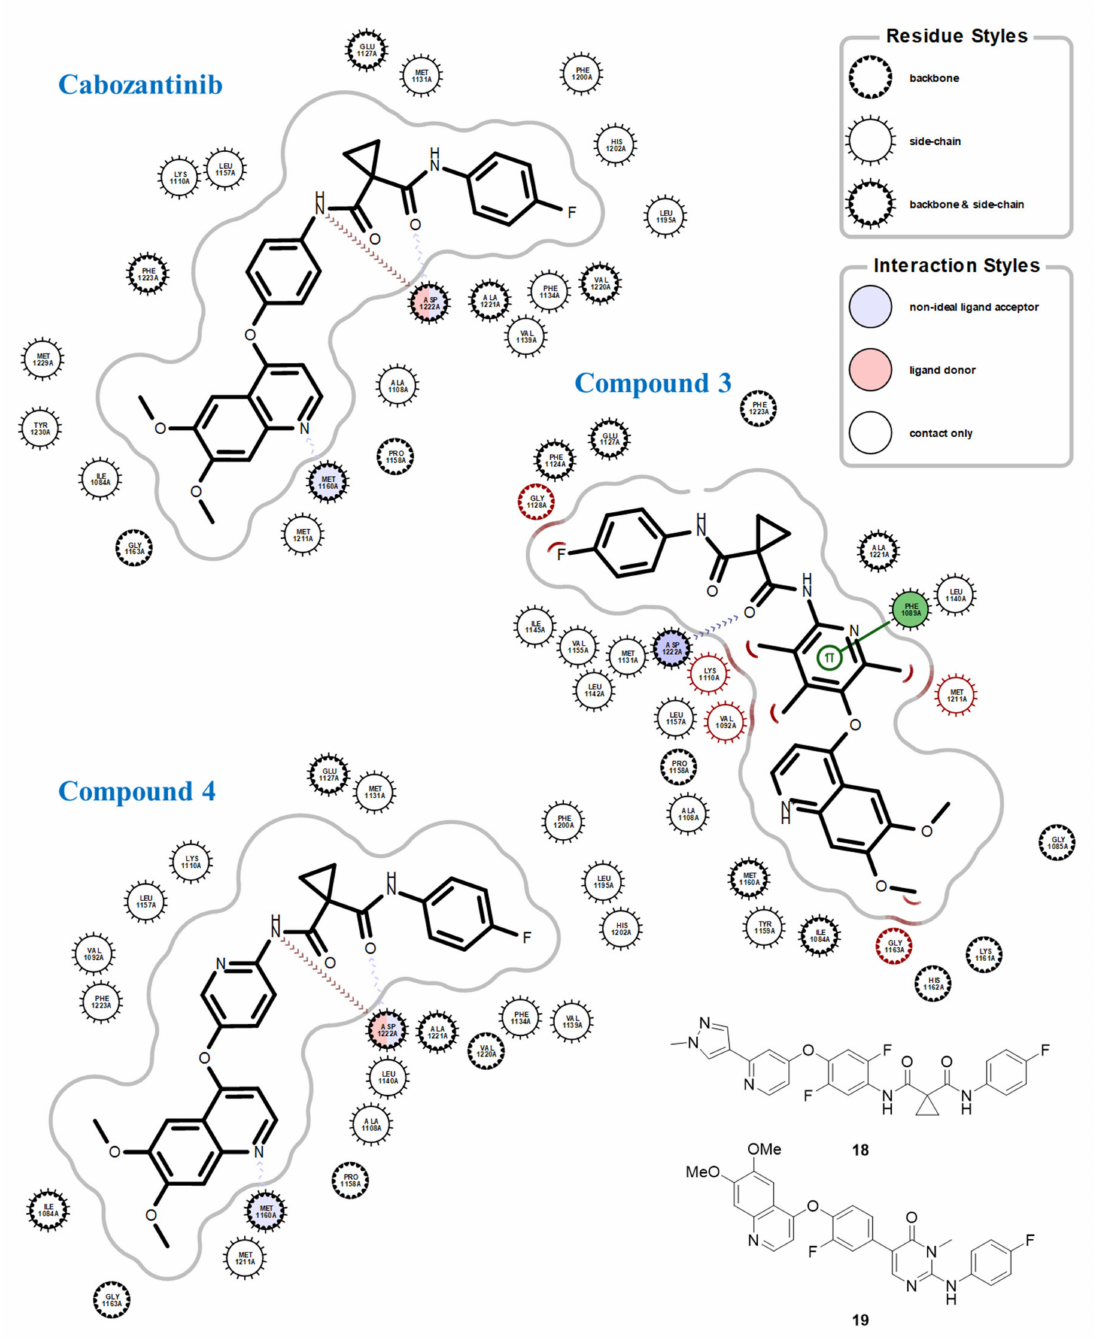
Figure 2. 2D diagram for the intermolecular interaction between the modeled small molecules and c -Met. The shape comparison of the small molecule ensemble and 63 crystal ligands generated the closest molecule as a pose using ROCS. The poses then replaced the crystal ligands with the corresponding c -Met coordinates. The used PDB codes for cabozantinib and compound 4 and compound 3 were 5DG5 and 3EFK, respectively. The annotations followed the convention by Openeye package